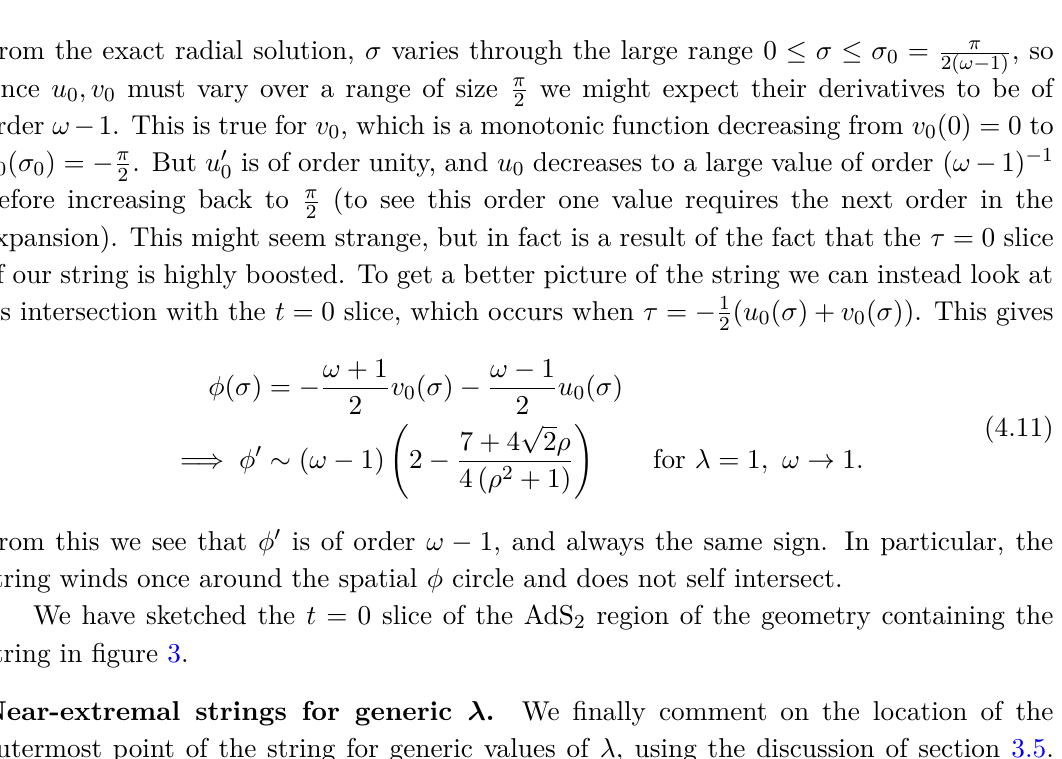
Figure 3 . A sketch of the spatial geometry of a t = 0 slice in the near-extremal AdS 2 region containing the string. The angular direction around the cylinder corresponds to the periodic φ coordinate, and the direction along the cylinder to the radial ρ coordinate. Going to the right (increasing ρ ) moves away from the AdS region, where the radius of the circle increases: this 2 change of radius becomes important only for ρ (cid:29) 1 , but has been exaggerated in the figure for illustrative purposes. The geometry is terminated at the left end by the string (marked in red), and the two sides of the string lying on either side of the cusp are identified. Note that this identification does not occur within this slice, identifying points with different values of t